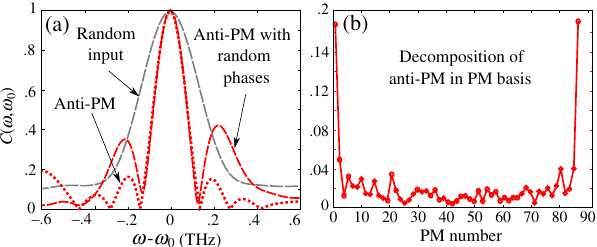
FIG. 4. Numerically determined anti-PM in a fiber without MDL. (a) Spectral correlation function of the narrowest anti-PM (red dotted line), which is significantly narrower than that of the random input (gray dashed line). The red dashed line is obtained by randomizing the phases of constituent PMs in the anti-PM. The phase randomization does not change the main peak, but it enhances the two side peaks. (b) The decomposition of this anti- PM in the PM basis shows two pronounced maxima at the extreme values of the involved PMs, indicating that anti-PMs are efficiently formed by combining the fastest and the slowest PMs. The data shown here result from the numerical simulation of a waveguide with 200 μ m width, 0.22 numerical aperture, 1 meter length, and no